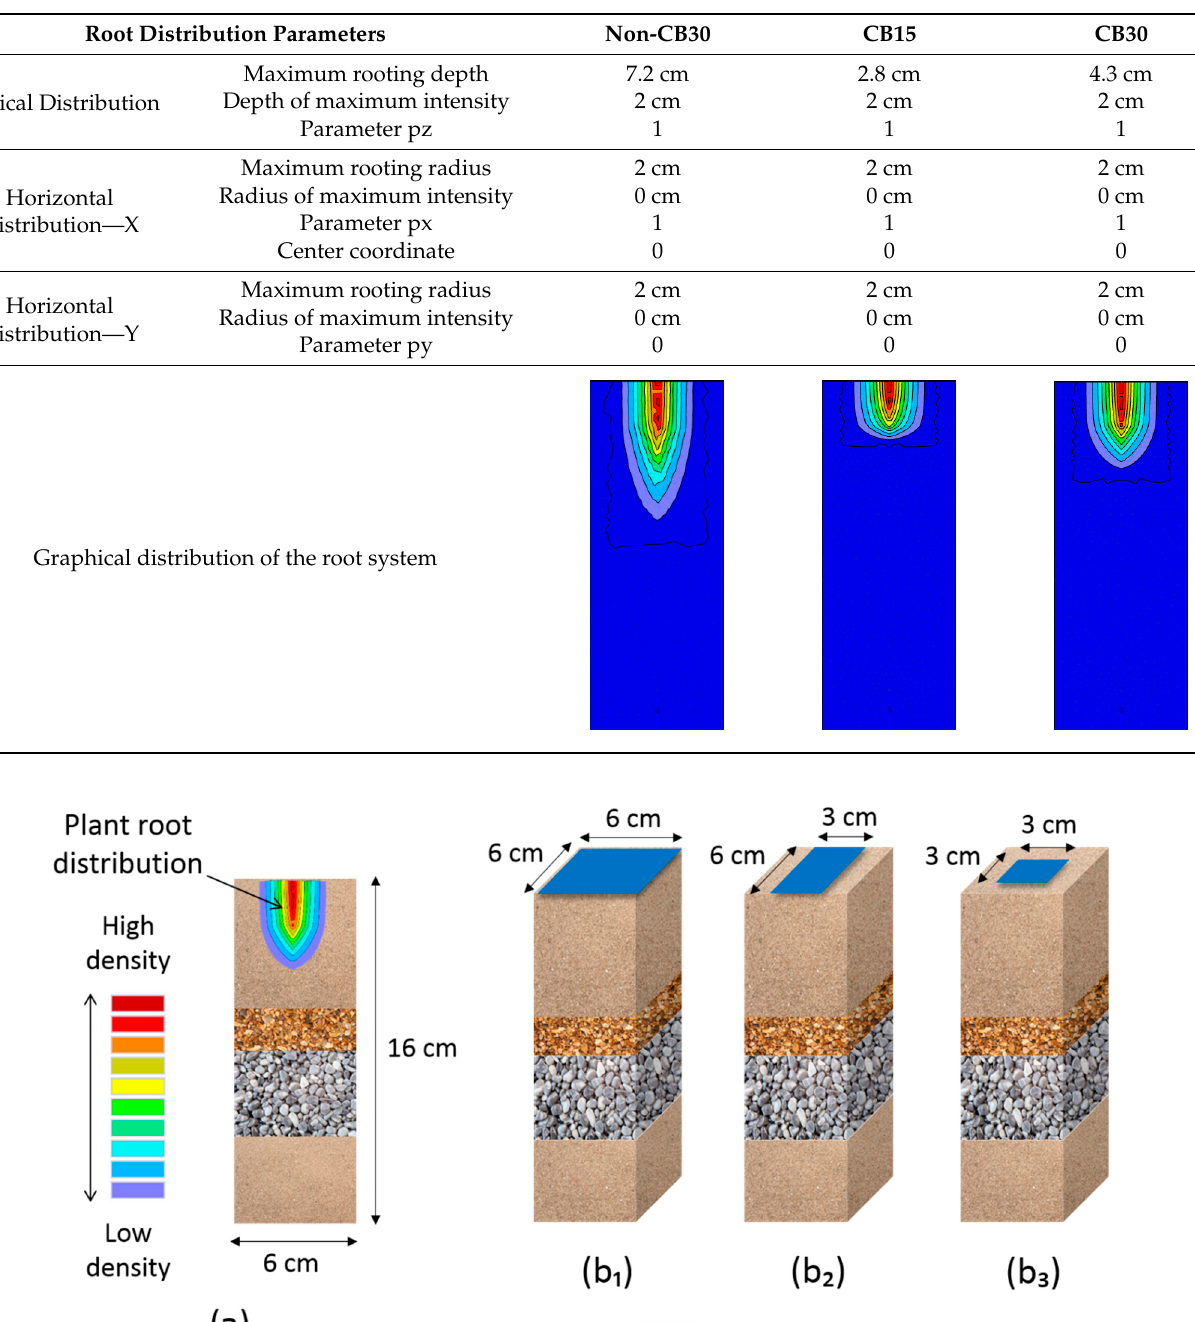
Table 3. Parameters for the Vrugt root distribution model [30] for different experimental scenarios (Non-CB30—A homoge- neous reference column and daily irrigation of 0.30 cm, CB15—A column with a CB and daily irrigation of 0.15 cm, and CB30—A column with a CB and daily irrigation of 0.30 cm) based on root data from Miyake et al. [20].